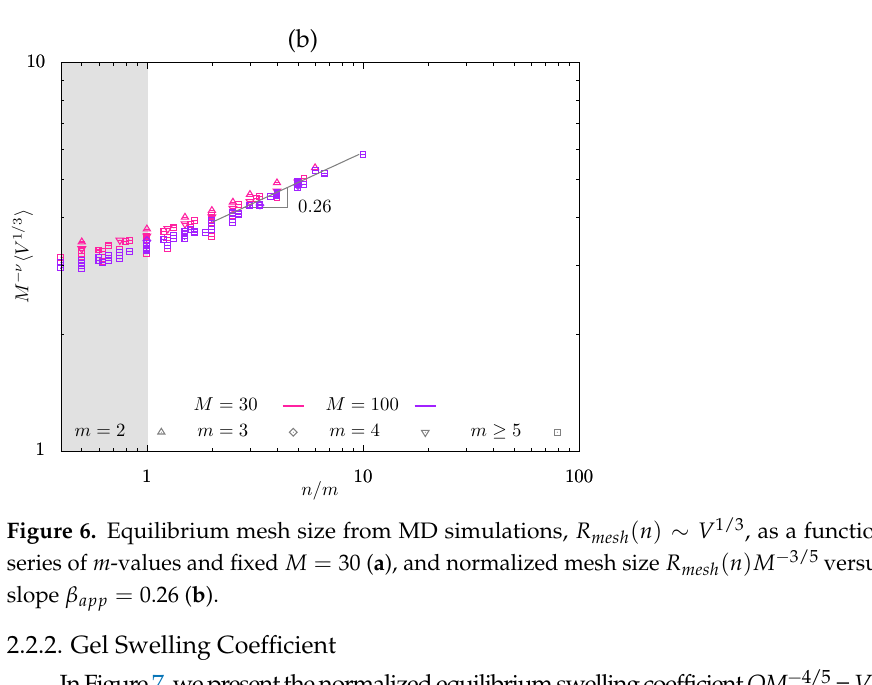
Figure 6. Equilibrium mesh size from MD simulations, R mesh ( n ) series of m -values and fixed M = 30 ( a ), and normalized mesh size R mesh ( n ) M − 3/5 versus n / m with slope β app = 0.26 ( b